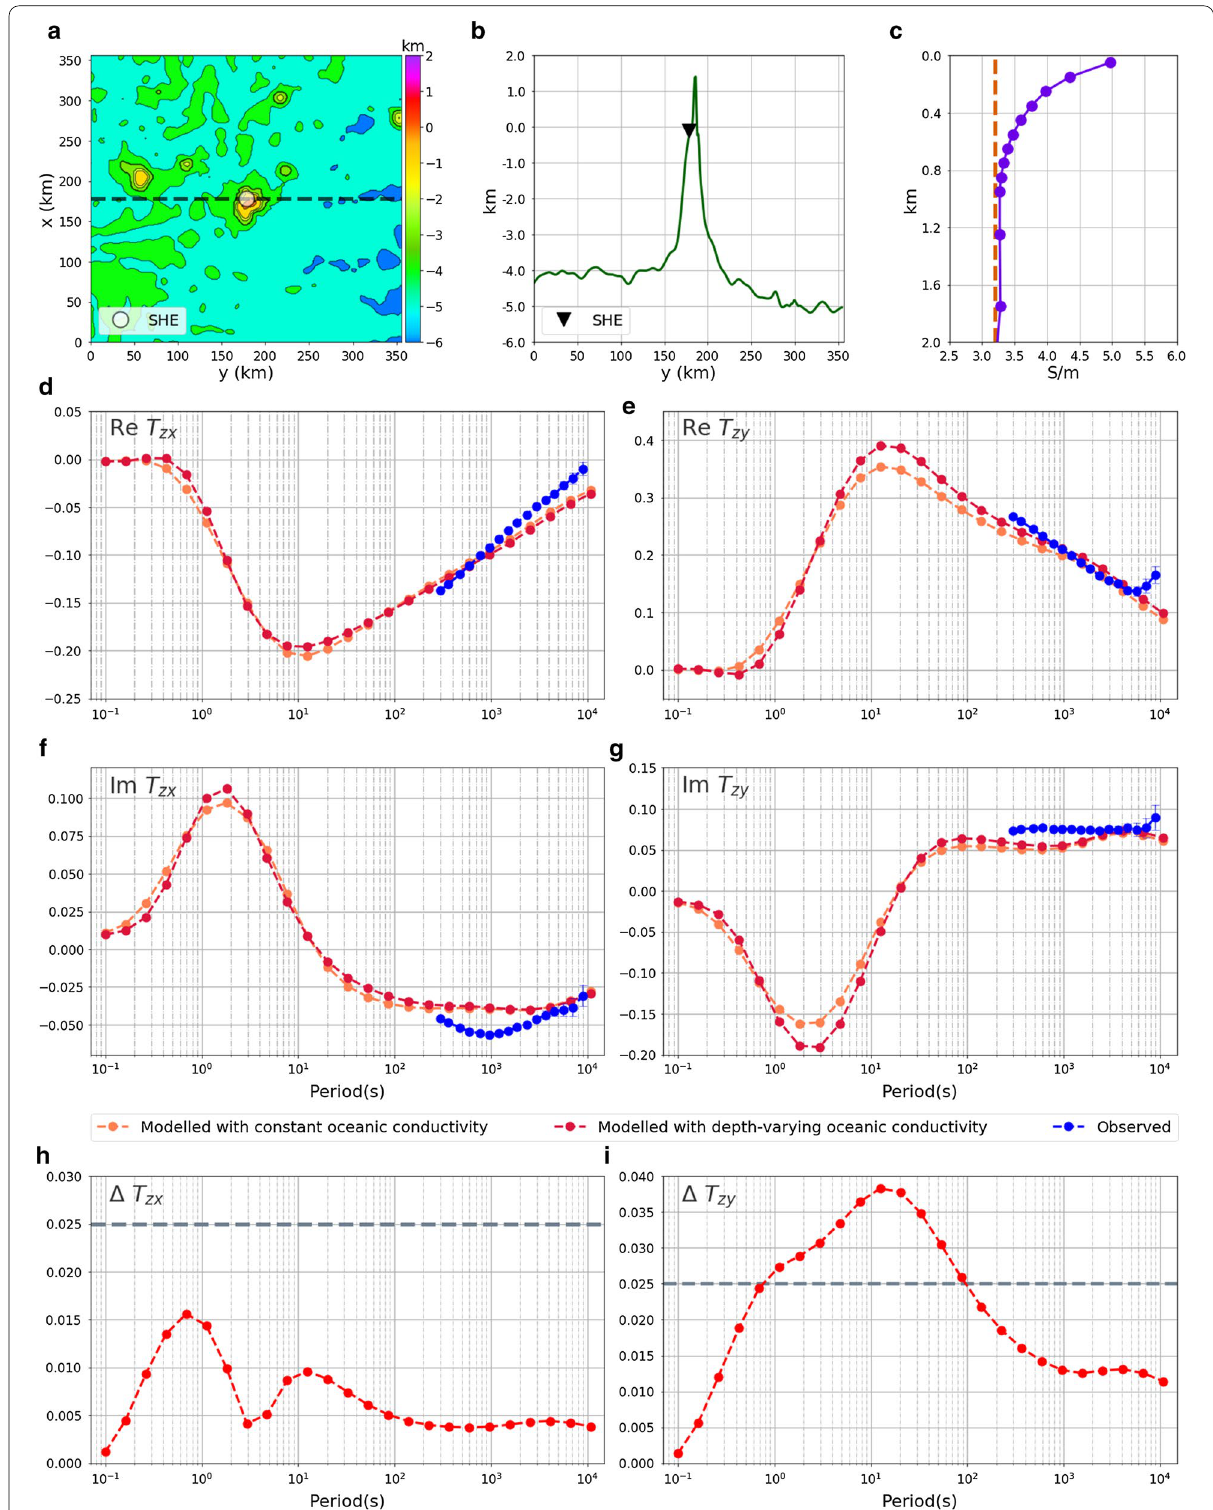
Fig. 13 Same as Fig. 5, but for St. Helena observatory